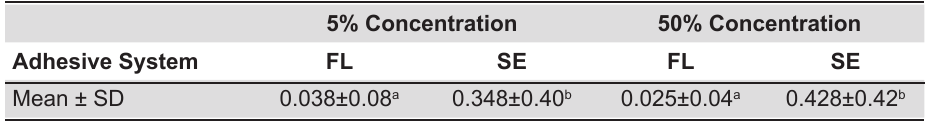
Table 2- Mean values (mm) ± standard deviations (SD) of tracer penetration in deciduous teeth regarding adhesive systems according to concentration of solutions, as well as, statistical significance*